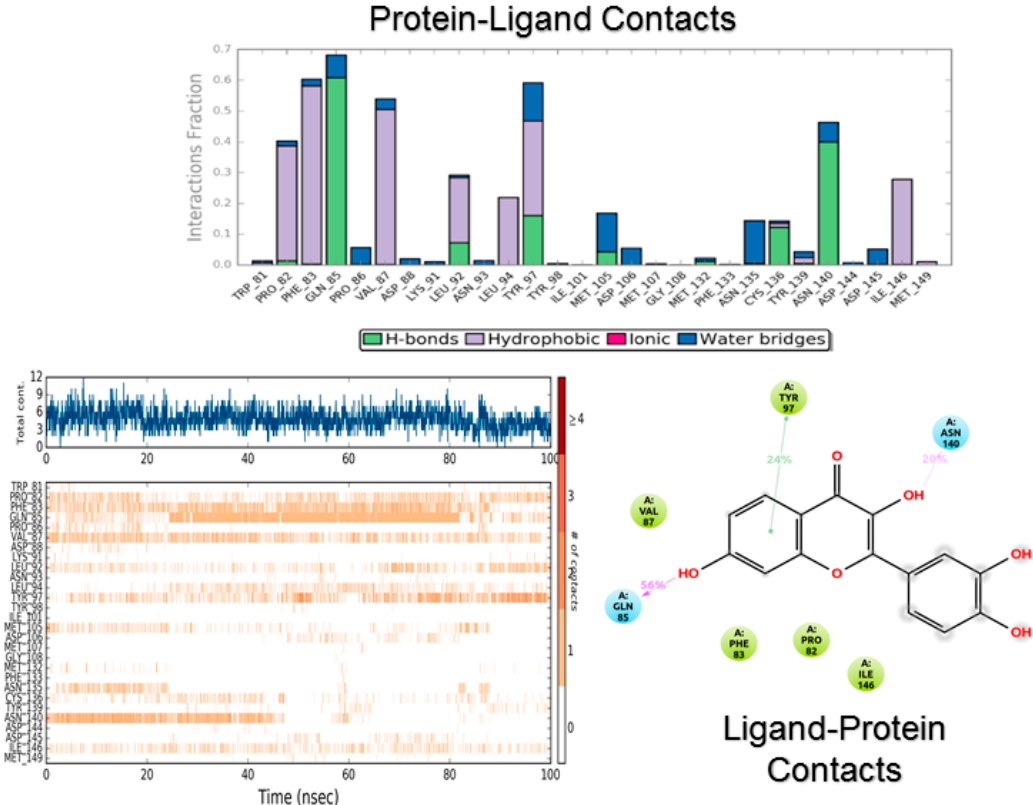
Figure 8. Protein–ligand contact analysis for fisetin during the MD simulation.